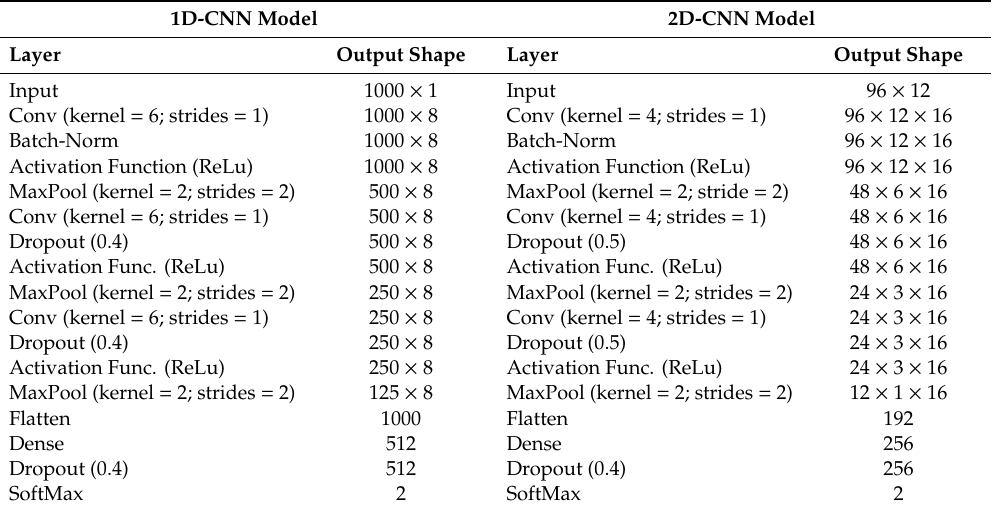
Table 10. Summary of 1D-CNN and 2D-CNN model configurations in